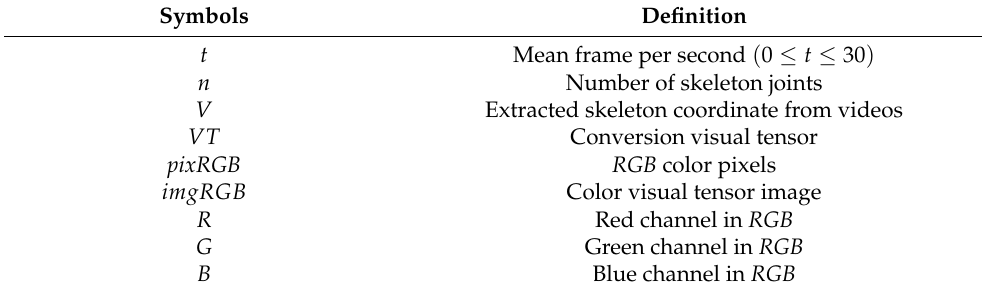
Table 3. Summary of